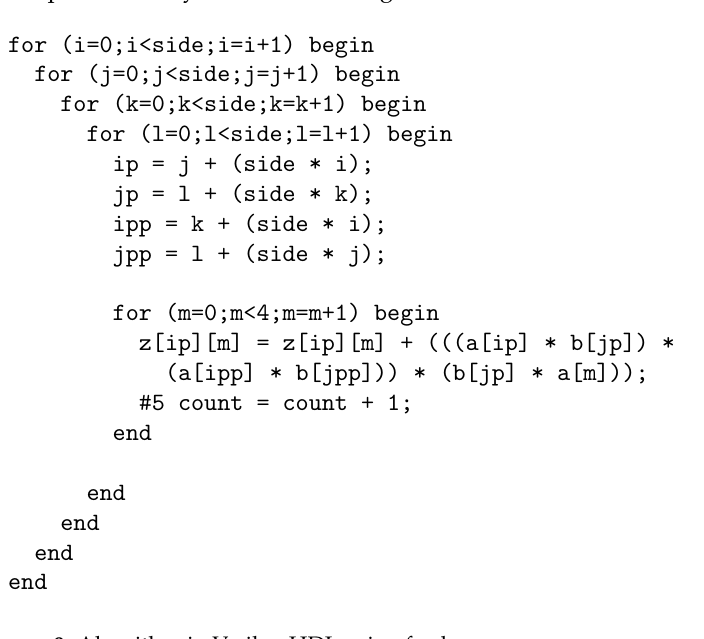
Figure 9. Algorithm in Verilog HDL using for-loops. Example